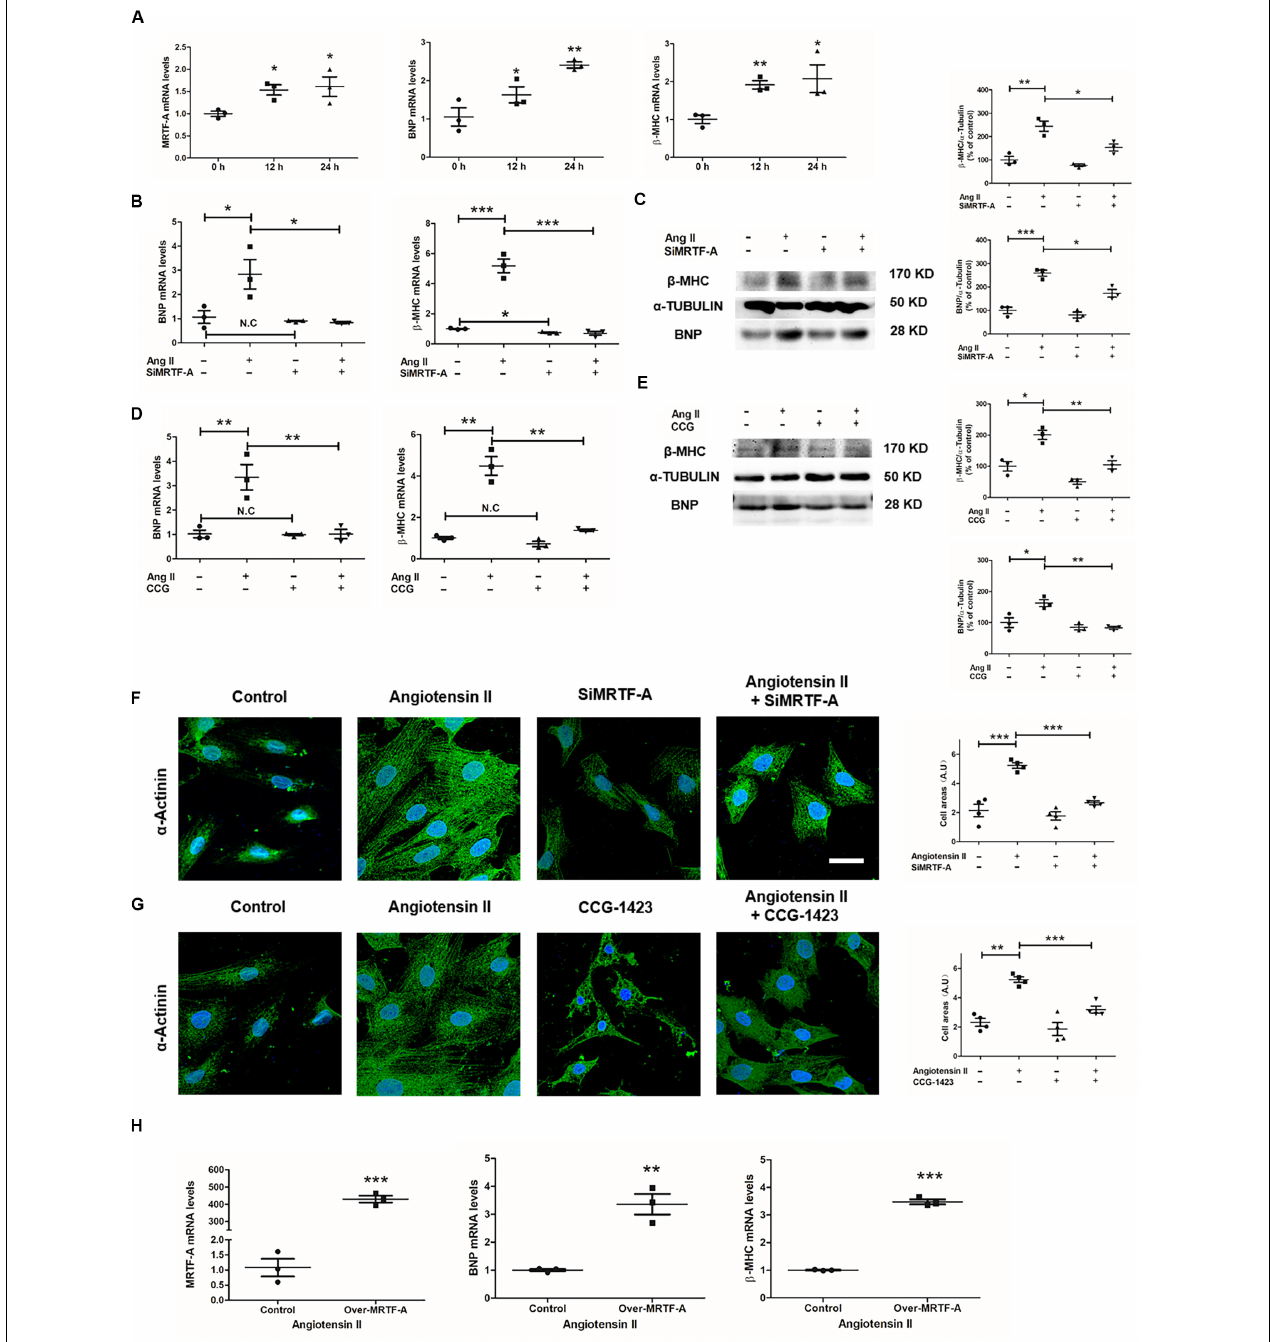
FIGURE 2 | Myocardin-related transcription factor A (MRTF-A) depletion or inhibition attenuates Ang-II-induced cardiomyocyte hypertrophy in vitro . (A) H9C2 cells were treated with or without Ang II (1 µ M) and harvested at indicated time points. Gene expression was examined by quantitative PCR (qPCR). (B,C) H9C2 cells were transfected with small interfering RNA (siRNA) targeting MRTF-A or scrambled siRNA (SCR) followed by treatment with Ang II (1 µ M) for 24 h. Gene expression was examined by qPCR and Western blot. (D,E) H9C2 cells were treated with Ang II (1 µ M) and CCG-1423 (10 µ M) for 24 h. Gene expression was examined by qPCR and Western blot. (F) H9C2 cells were transfected with siRNA targeting MRTF-A or scrambled siRNA (SCR) followed by treatment with Ang II (1 µ M) for 24 h. Immunofluorescence staining was performed with anti- α -actinin. Cross-sectional areas were quantified by Image Pro. (G) H9C2 cells were treated with Ang II (1 µ M) and CCG-1423 (10 µ M) for 24 h. Immunofluorescence staining was performed with anti- α -actinin. Cross-sectional areas were quantified by Image Pro. (H) H9C2 cells were treated with Ang II (1 µ M) and transfected with MRTF-A expression plasmid for 24 h. Gene expression was examined by qPCR. Data represent averages of three independent experiments and error bars represent SEM. * p < 0.05; ** p < 0.01; *** p < 0.001. Scale bar: 25 µ m.